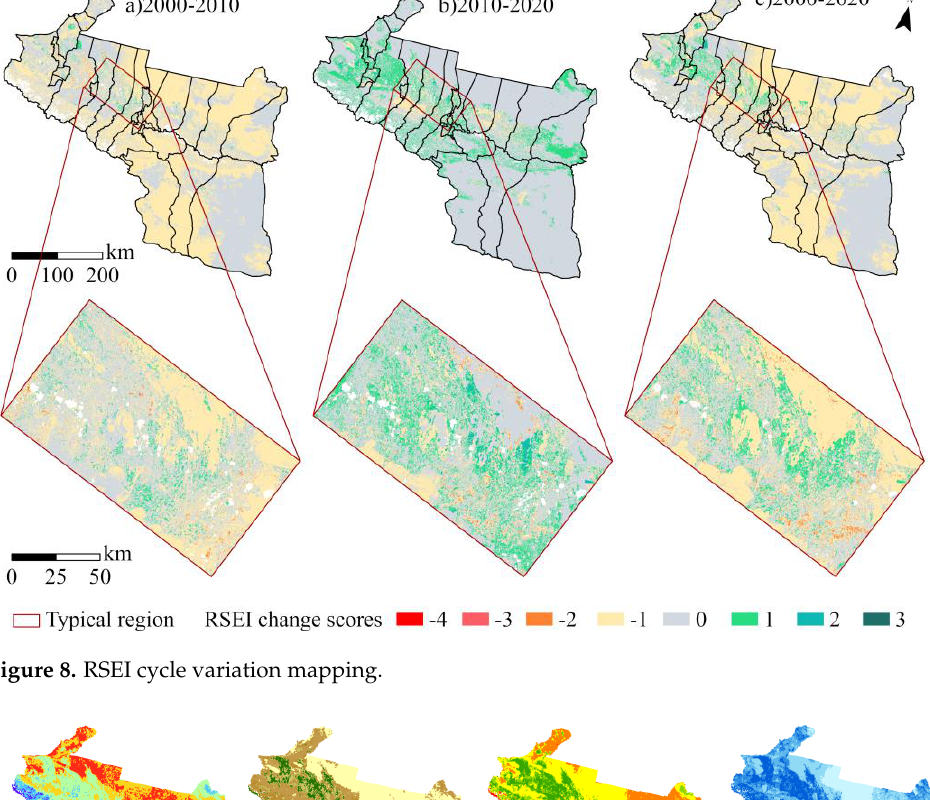
Figure 8. RSEI cycle variation mapping.